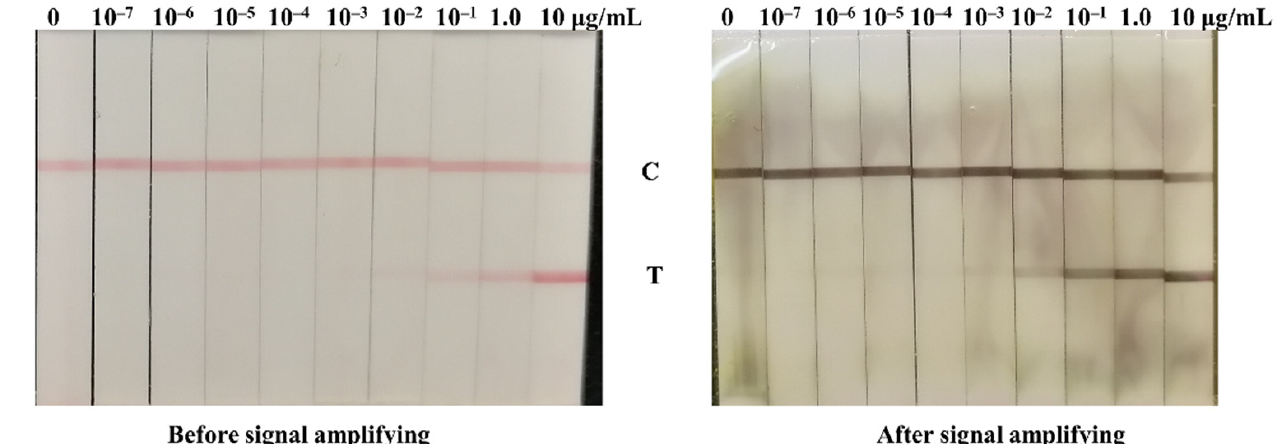
Figure 2. Comparison of the detection sensitivity before and after signal amplifying introduced by copper deposition.